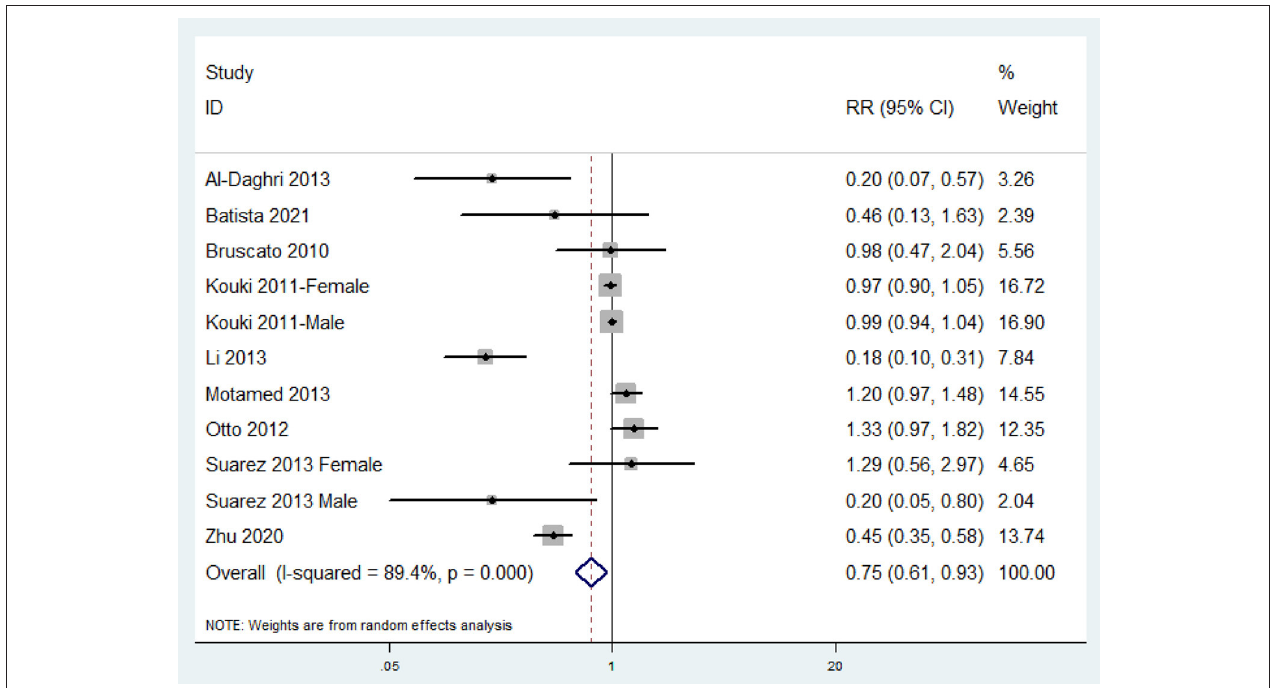
FIGURE 2 | Forest plot of meta-analysis: Overall multi-variable adjusted RR of MetS for the highest vs. lowest dietary zinc intake